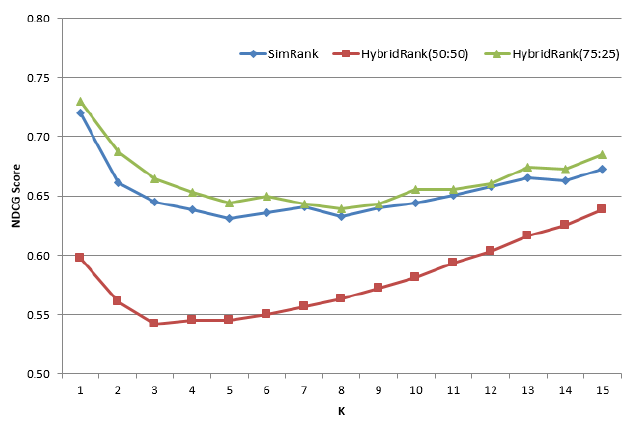
Figure 3. Comparison of the NDCG average score of three different rankings . . Furthermore, ANOVA is employed for top 15 ranks. Assume that the sample comes from populations that are approximately normal with equal variances. Level of significance is set to 0.05 ( 